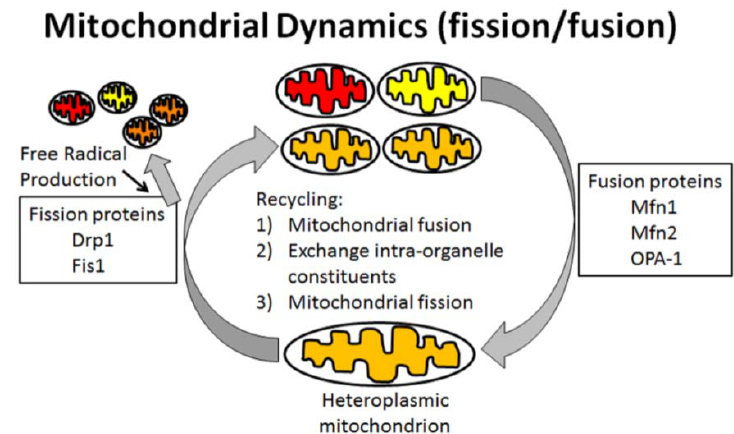
Figure 3. Illustration showing mitochondrial dynamics in a healthy neuron. Mitochondrial fission and fusion are the means by which mitochondria are recycled. Dilution of damaged mitochondrial constituents occurs by this process thereby extending the lifespan of otherwise non-functional organelles. Oxidative stress within the cell is known to result in mitochondrial fragmentation which disrupts normal mitochondrial